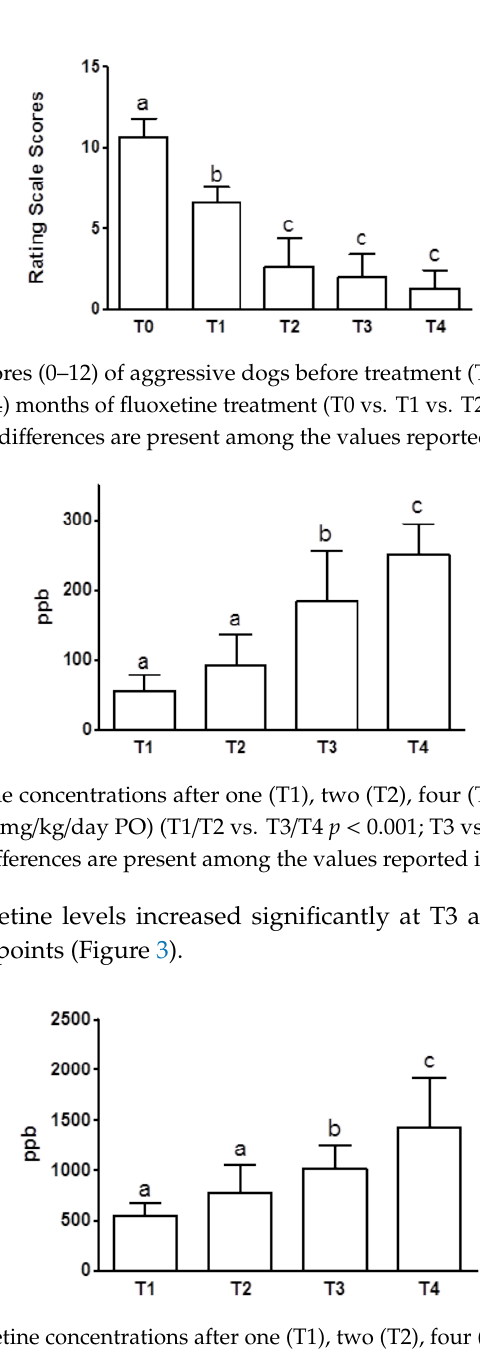
Figure 3. Blood norfluoxetine concentrations after one (T1), two (T2), four (T3), and six (T4) months of fluoxetine treatment (1.5 mg/kg/day PO) (T1/T2 vs. T3/T4 p < 0.01; n = 8). a, b, c: statistically significant differences are present among the values reported in the bar of the graph.